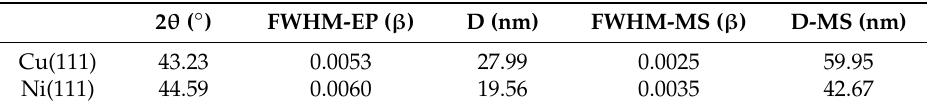
Table 1. Grain size calculated from XRD data.